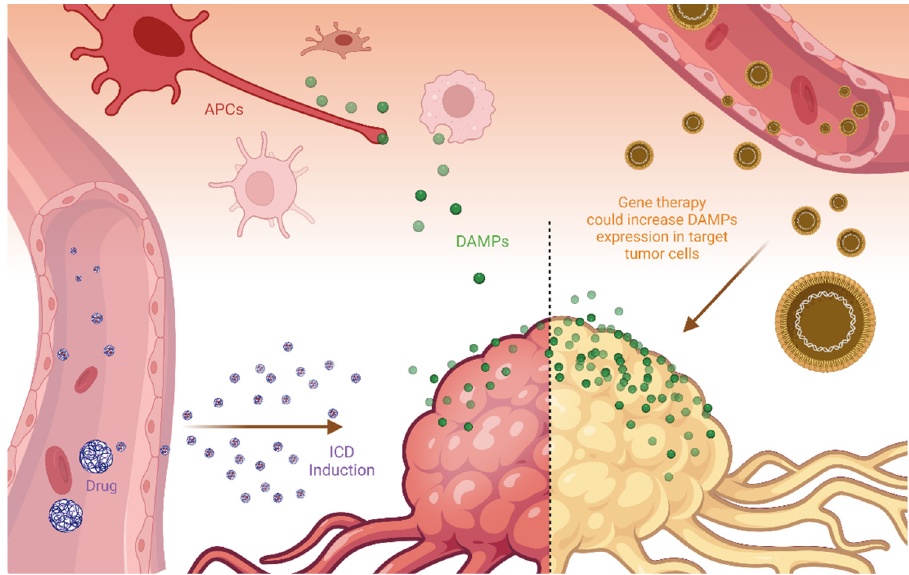
Figure 3. The induction of immunogenic cell death (ICD), the exposure of damage-associated molecular patterns (DAMPs), and the activation of antigen-presenting cells (APC) can be enhanced by delivery strategies based on nanotechnology.